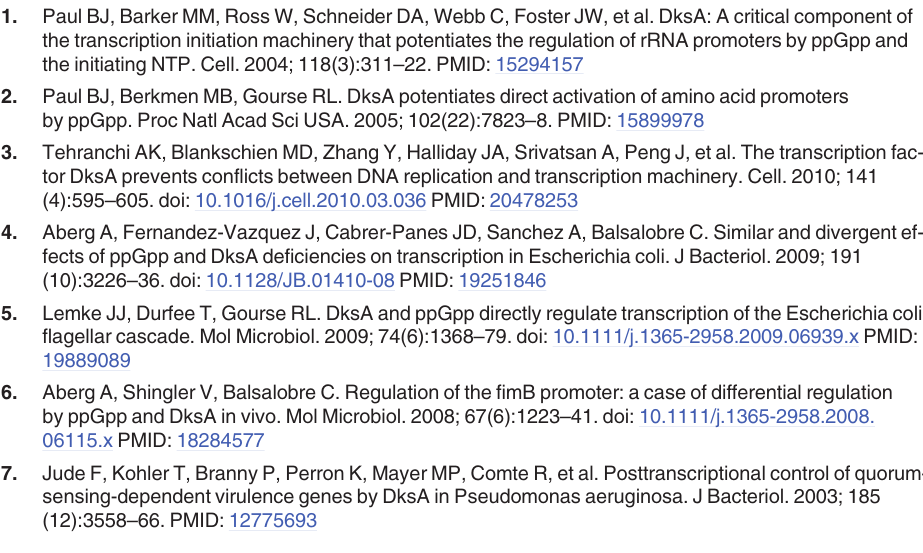
R values were calculated based on 50 values for DksA in- 50